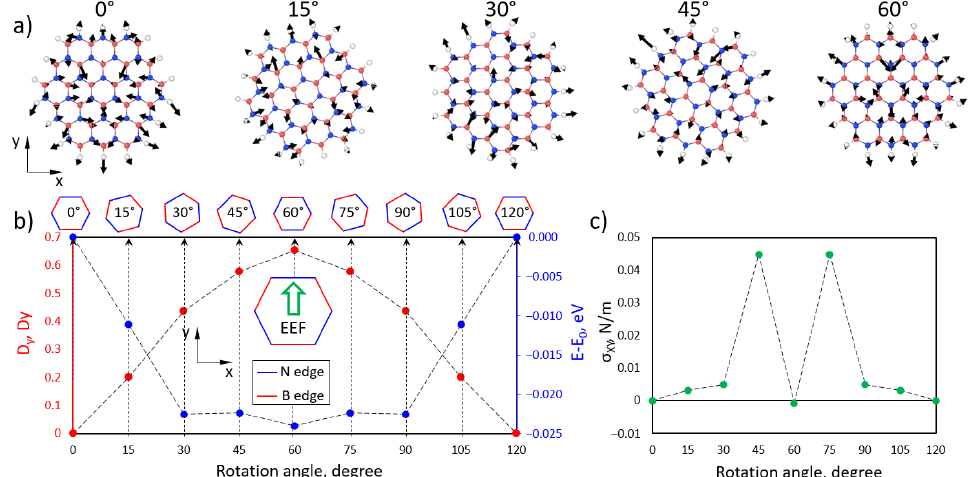
Figure 9. ( a ) Atomic structure of BN flakes with calculated atomic forces (black arrows) under the influence of the EEF. ( b ) Dependence of the y-component of the BN flake dipole moment (red dots) and total energy (blue dots) on the rotation angle in the xy direction. ( c ) Dependence of the xy components of the mechanical stress tensor on the rotation angle.